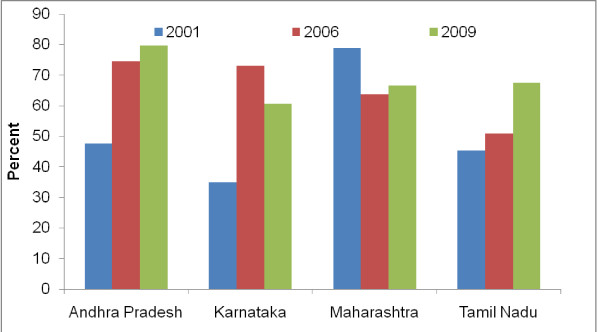
Men in reproductive age reporting condom use during last sex act with a non-regular sex partner.